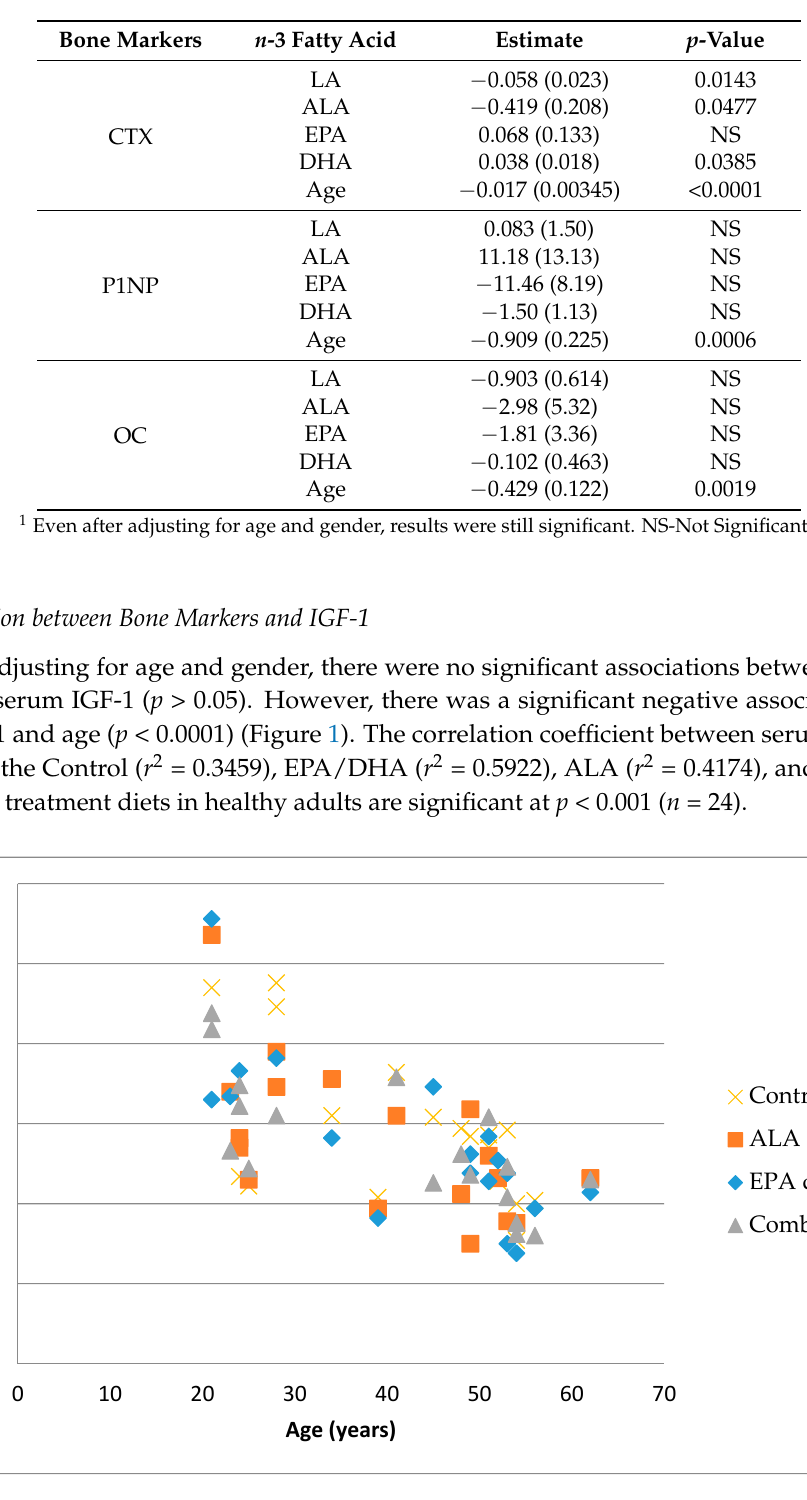
Table 2. Association between bone markers with individual n -3 fatty acids and age 1 .